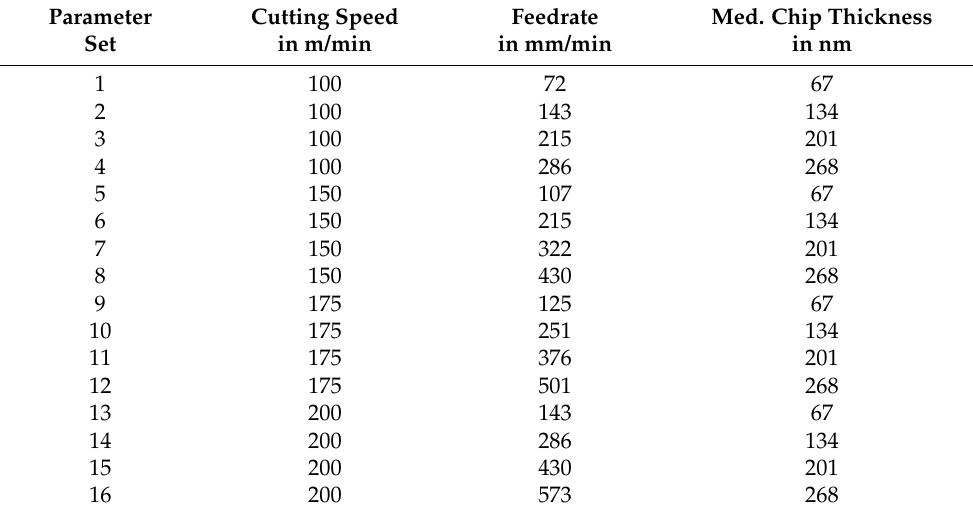
Table 4. Overview of the third experiment